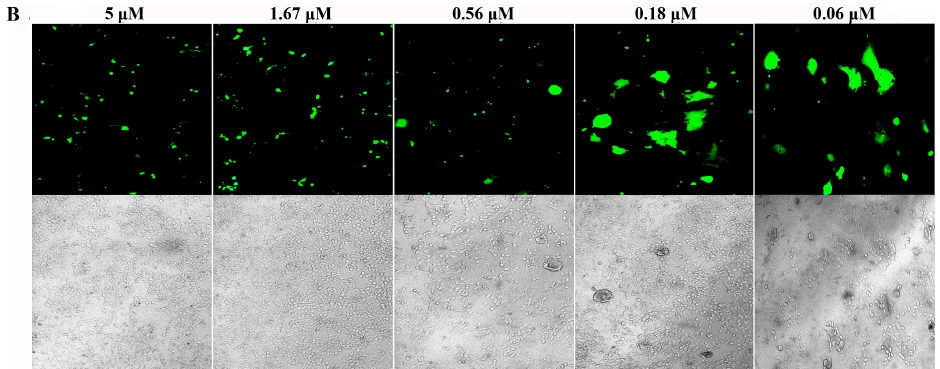
Figure 4. Inhibition by MERS-5HB of MERS-CoV S protein-mediated syncytium formation. ( A ) Images of S protein-mediated cell–cell fusion. Huh-7/EGFP cells and 293T/MERS-S cells were co-cultured at the ratio of 1:1, 3:1, 9:1; 293T/vector cells were tested as control. ( B ) Inhibition of